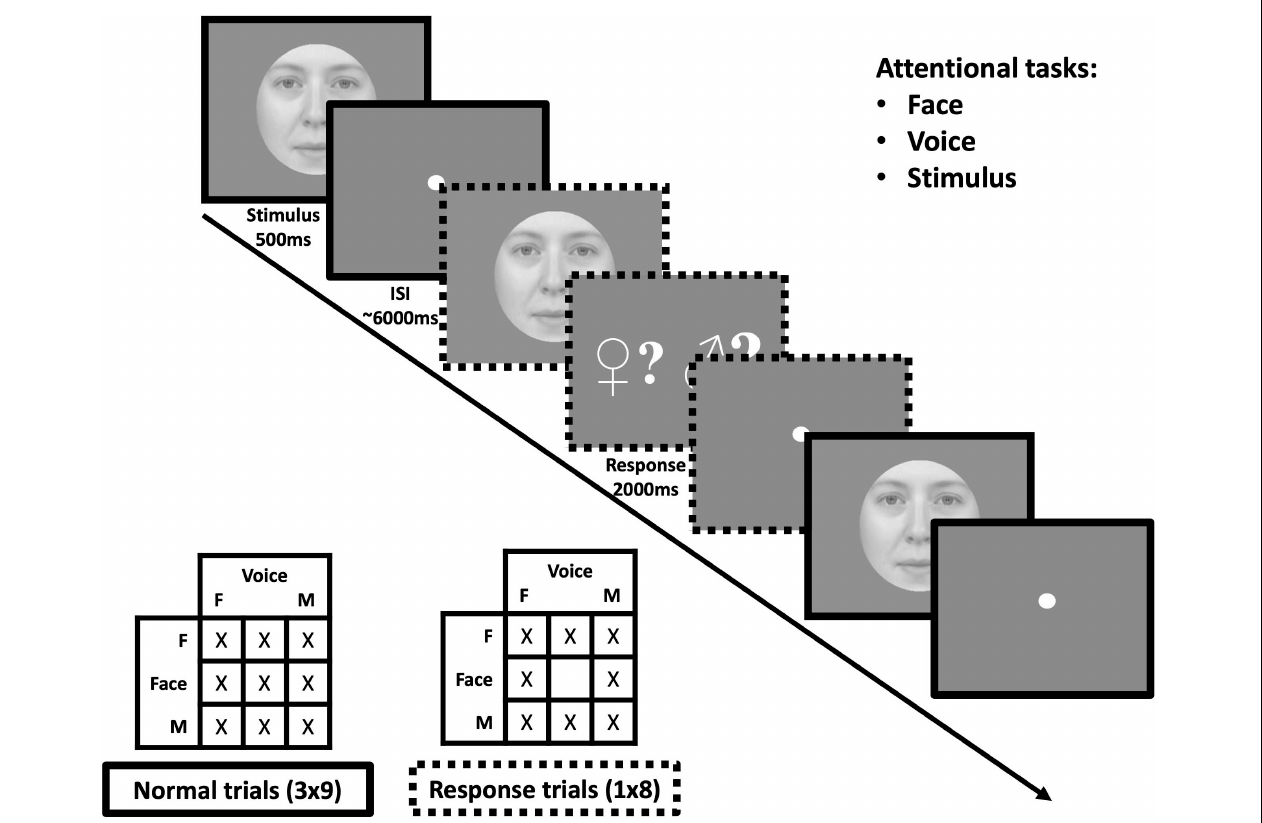
FIGURE 2 | Protocol for one acquisition of the face-voice gender fMRI experiment. (Top-right) Within sessions, subjects were assigned the task to pay attention to face, voice or stimulus gender. (Middle) subjects were presented with face-voice stimuli in succession in an event-related manner. On some trials, subjects received a signal to respond as to whether the gender of the modality attended was masculine or feminine for the previous stimulus (note that in the actual protocol the masculine sign was presented in blue and the feminine sign in red). (Bottom-left) For each acquisition all nine face-voice gender combinations were presented three times in addition to eight “response” trials corresponding to all combinations except gender-neutral face + gender neutral